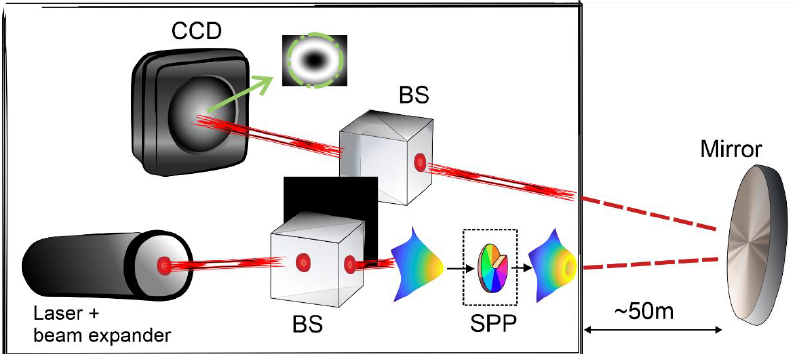
Figure 8. Diagram of an experimental system for detecting intensity with an additional shutter, BS—beam splitters, SPP—spiral phase plate.